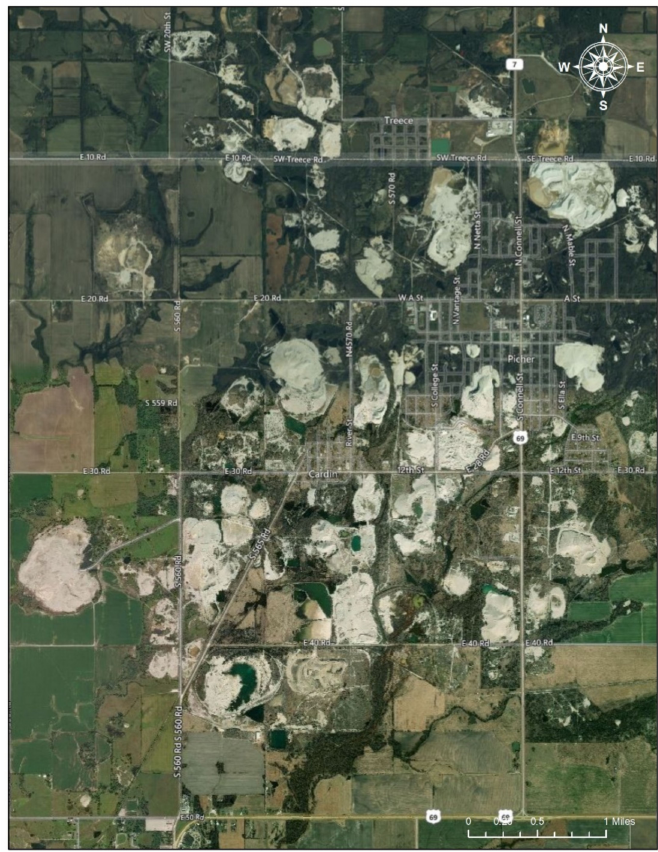
Figure 4. Mining Sites near Treece and Picher. Note: The satellite imagery shows areas with mining sites (the white areas in the picture) clustering near Treece and Picher, Oklahoma, in the Tar Creek Superfund Site (Date taken: 1 August 2020). The image in the Figure 4 is eligible for the Fair Use of a copyrighted work from Google Map